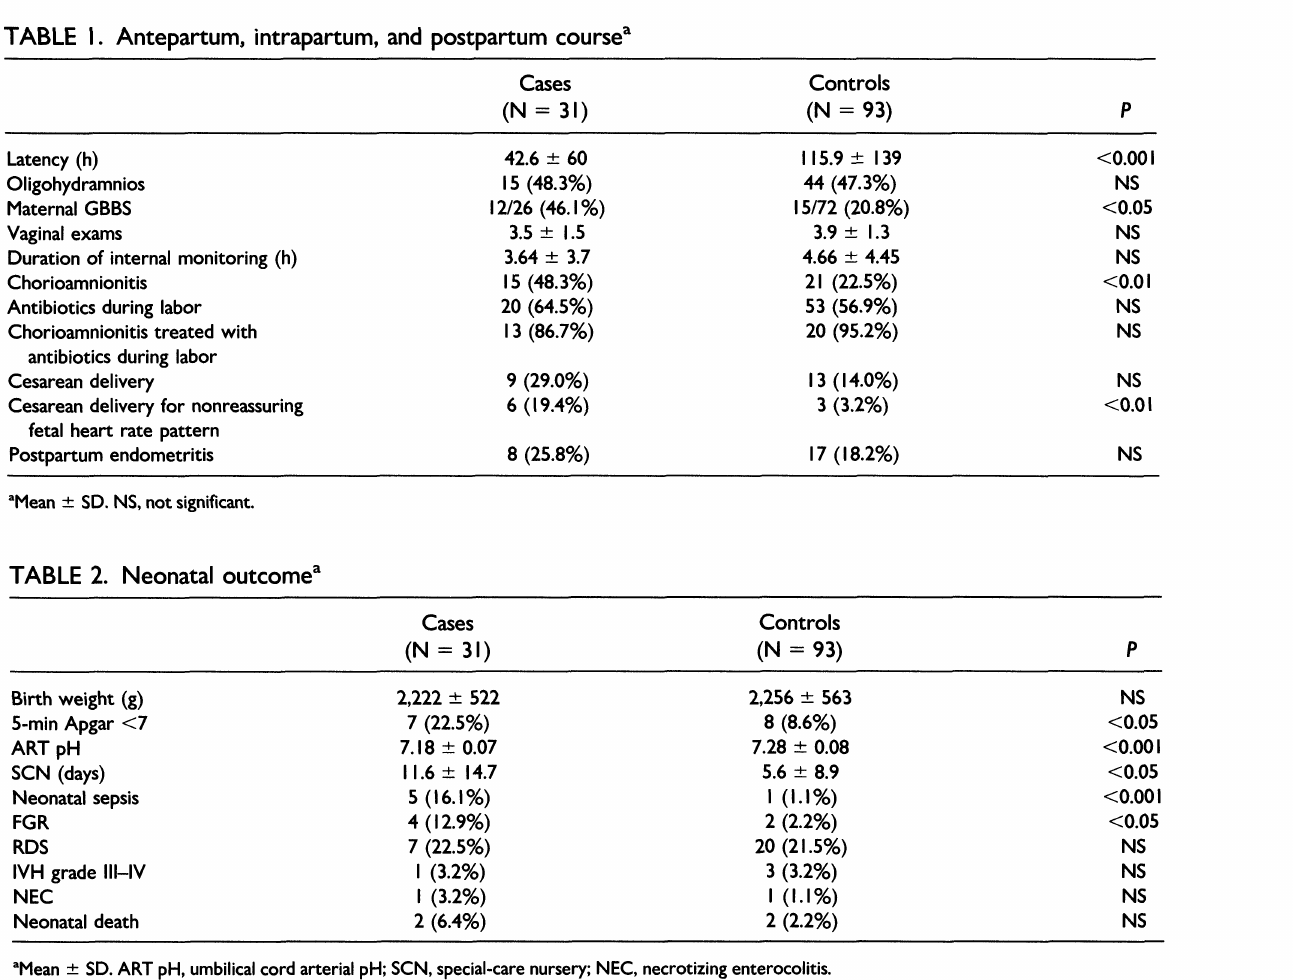
TABLE 2. Neonatal